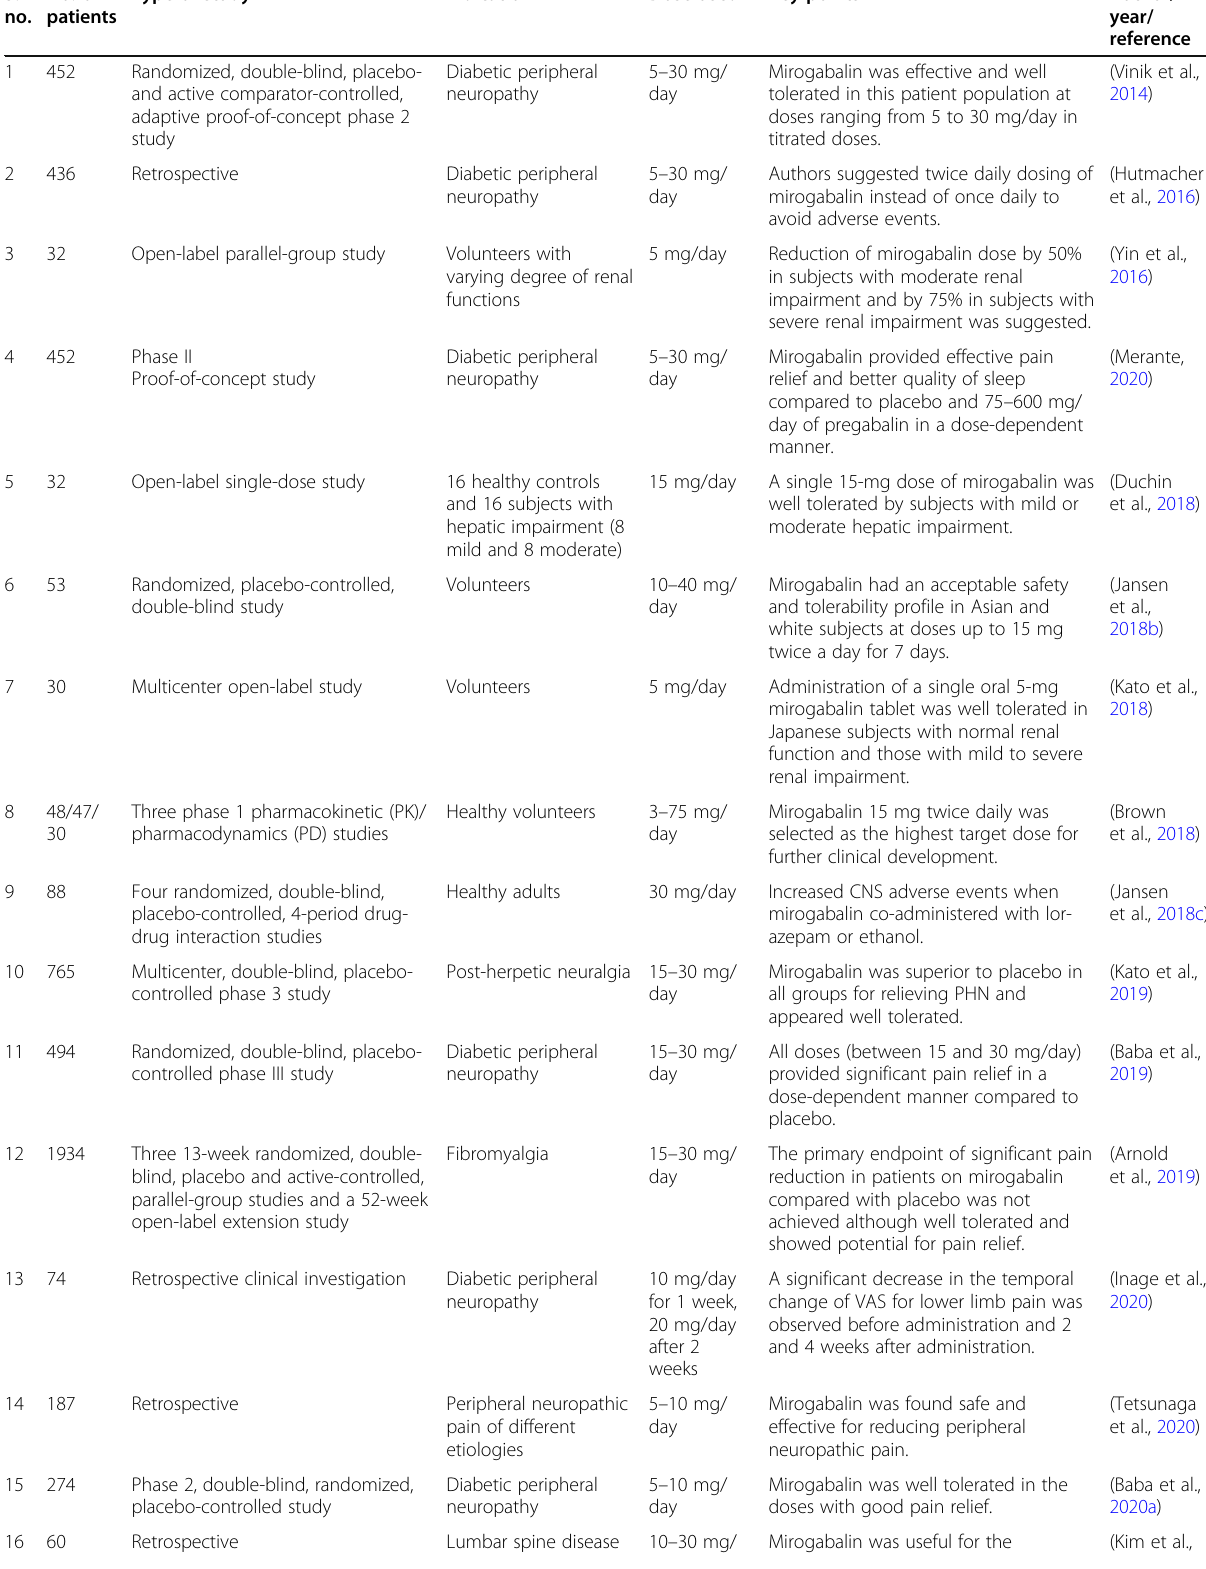
Table 1 Table showing studies in which mirogabalin was used in various chronic pain conditions S. No. of Type of no. patients